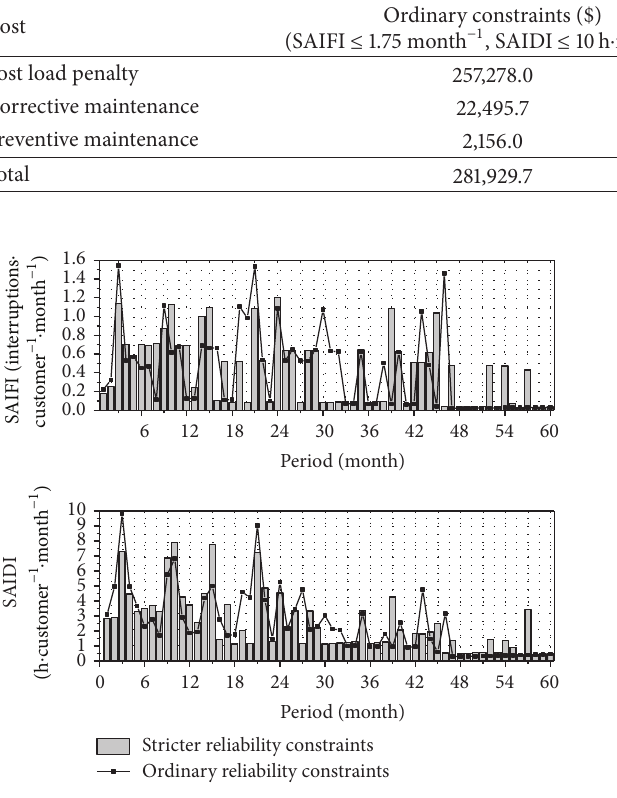
Figure 8: Reliability indices of each period with stricter reliability